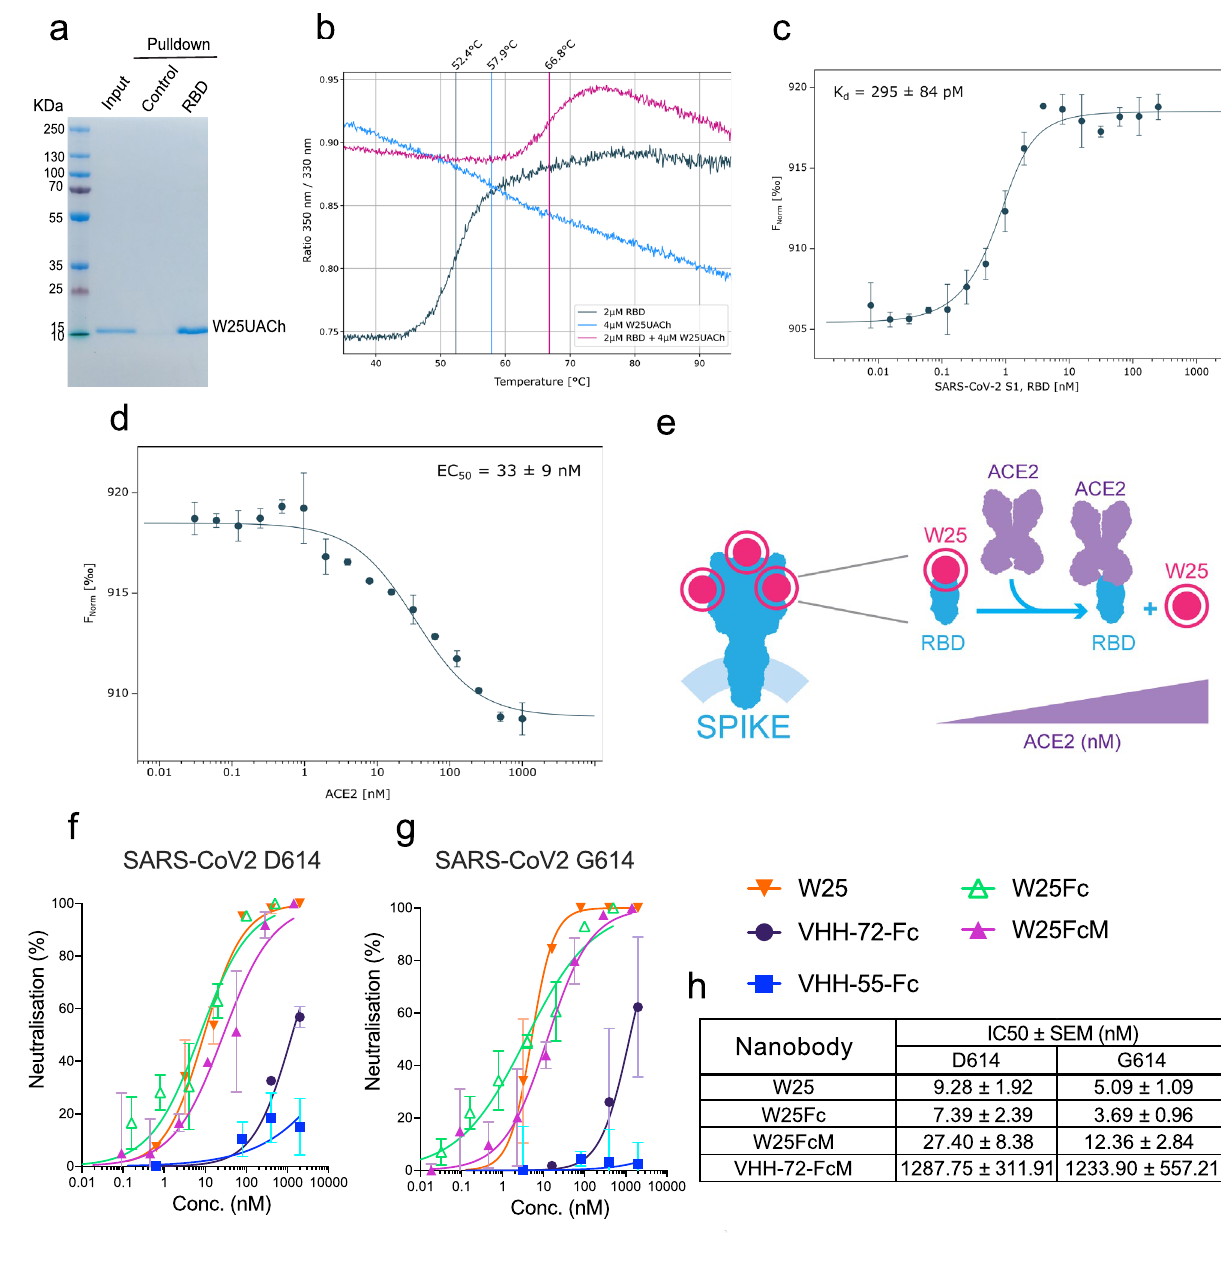
Figure 3. Binding characterization and neutralization of SARS-CoV-2 by the nanobody W25. ( a) Pulldown of the W25 nanobody. A recombinant Spike RBD domain of the SARS-CoV-2 spike protein or control BSA protein were covalently bound to NHS-sepharose beads. Further, the W25 nanobody was incubated with control and spike RBD beads, washed, and further eluted in LSD lysis buffer (Invitrogen). Original SDS-Page as supplemental Fig. 3b. ( b) Unfolding profiles of 2 µM SARS-CoV-2 S1, spike RBD in the absence (black) and presence (red) of 2 µM W25, measured with Tycho NT.6. Binding of W25 to spike RBD leads to strong stabilization and shifts the inflection unfolding temperature (T i ) from 52.1 to 66.3 °C. ( c) MST binding curve for the titration of 1 nM fluorescently labeled W25 into a 16-point serial dilution of SARS-CoV-2 S1, Spike RBD (250 nM to 7.6 pM). W25 binds Spike RBD with sub-nanomolar affinity (K d = 295 ± 84 pM). Error bars show the SD calculated from experiments performed in triplicate. ( d) MST competitive curve for 2 nM of fluorescently labeled W25 incubated with 4 nM SARS-CoV-2 RBD, titrated with a 16-point dilution series of hACE2 (1 µM to 30.5 pM). W25 is displaced by hACE2 with nanomolar concentration (EC50 = 33 ± 9 nM). Error bar show the SD calculated from triplicate experiments. ( e) Diagram of W25 and ACE2 competition for RBD of spike of SARS-CoV-2. ( f) Neutralization assay of SARS-CoV-2 life virus D624 variant with nanobody W25, W25 fused to monomeric Fc (W25FcM) and W25 fused to dimeric Fc (W25Fc) and the previously reported nanobodies VHH-72-Fc (monomeric) and VHH-55-Fc (monomeric). The independent experiments were normalized by percentage of neutralization. ( g) Neutralization assay of SARS-CoV-2 life virus D624 under similar condition as in ( g ). ( h) Comparative neutralization values of W25, W25FcM, W25Fc and VHH-72 FcM against SARS-CoV-2 D614 and G614 virus variants. Illustration (e) by Felipe G. Serrano BSc., MSc Scientific